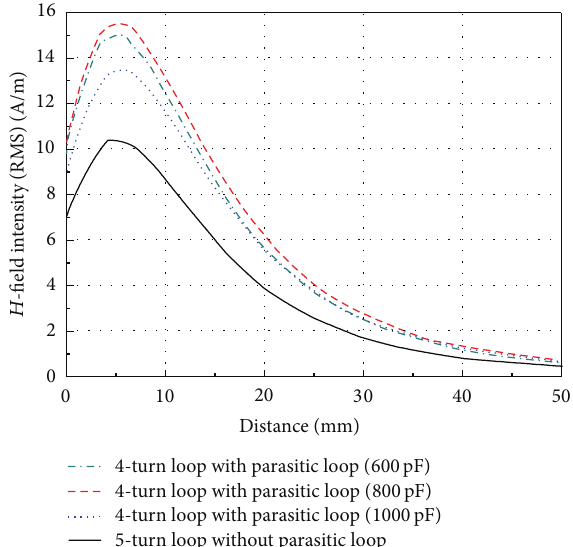
Figure 4: 𝐻 -field intensity along with a normal direction ( 𝑧 -axis) on the center of the loop antenna with varying capacitance of a capacitor embedded in the parasitic